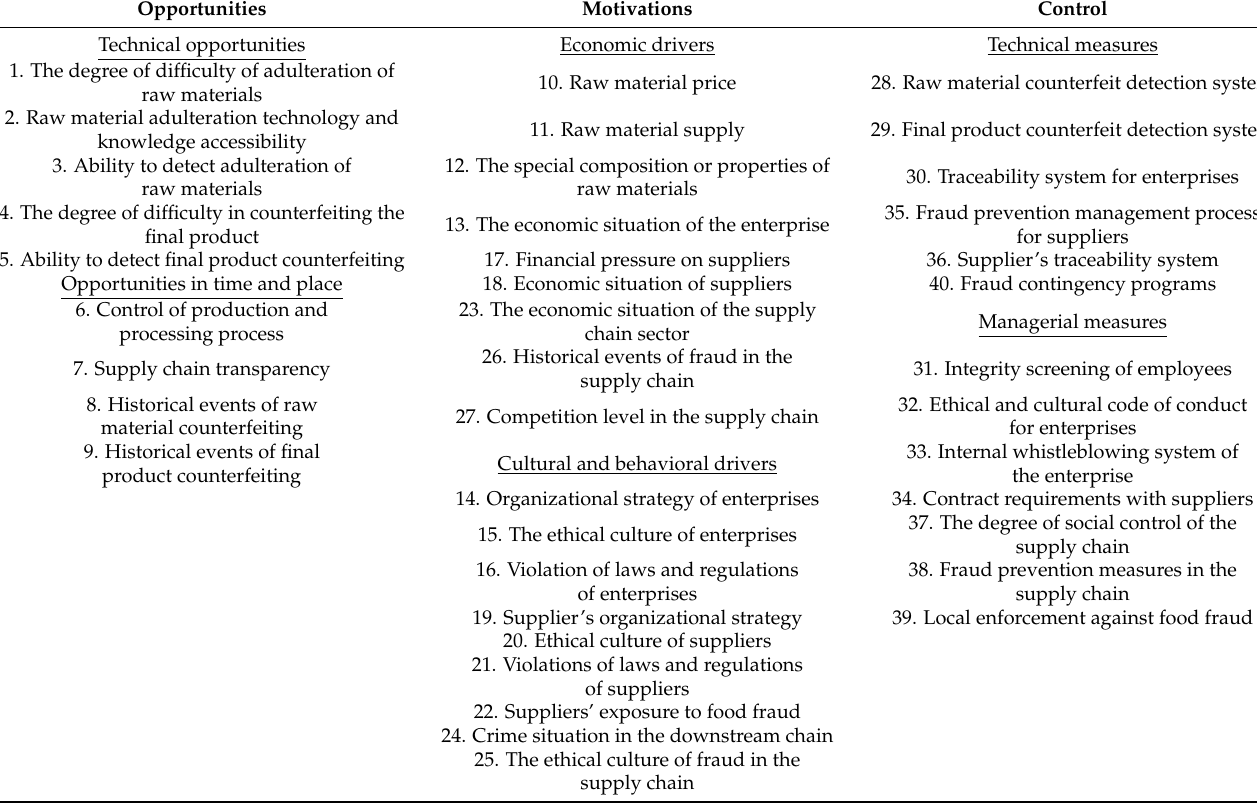
Table 1. The adjusted baijiu supply chain assessment index